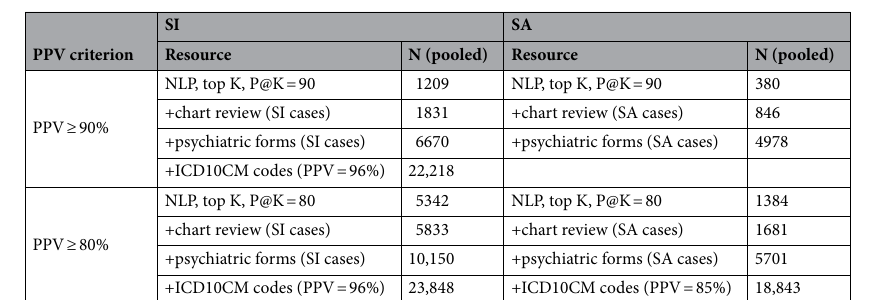
SI PPV criterion